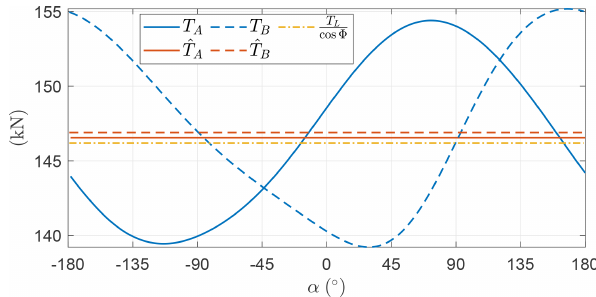
Figure 12. Tether force T as a function of the angular position.